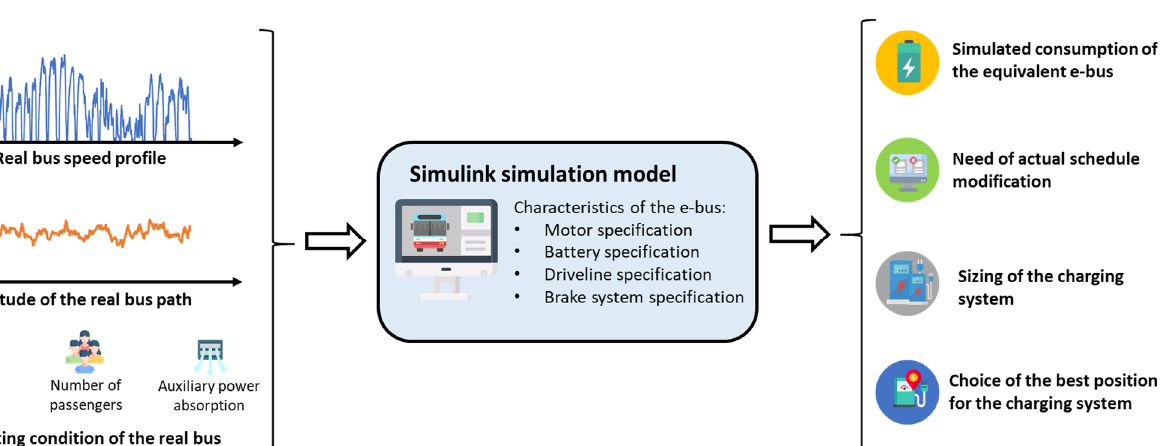
Figure 1. Electric bus registration and announced available models by region. Elaboration of data from IEA [13].